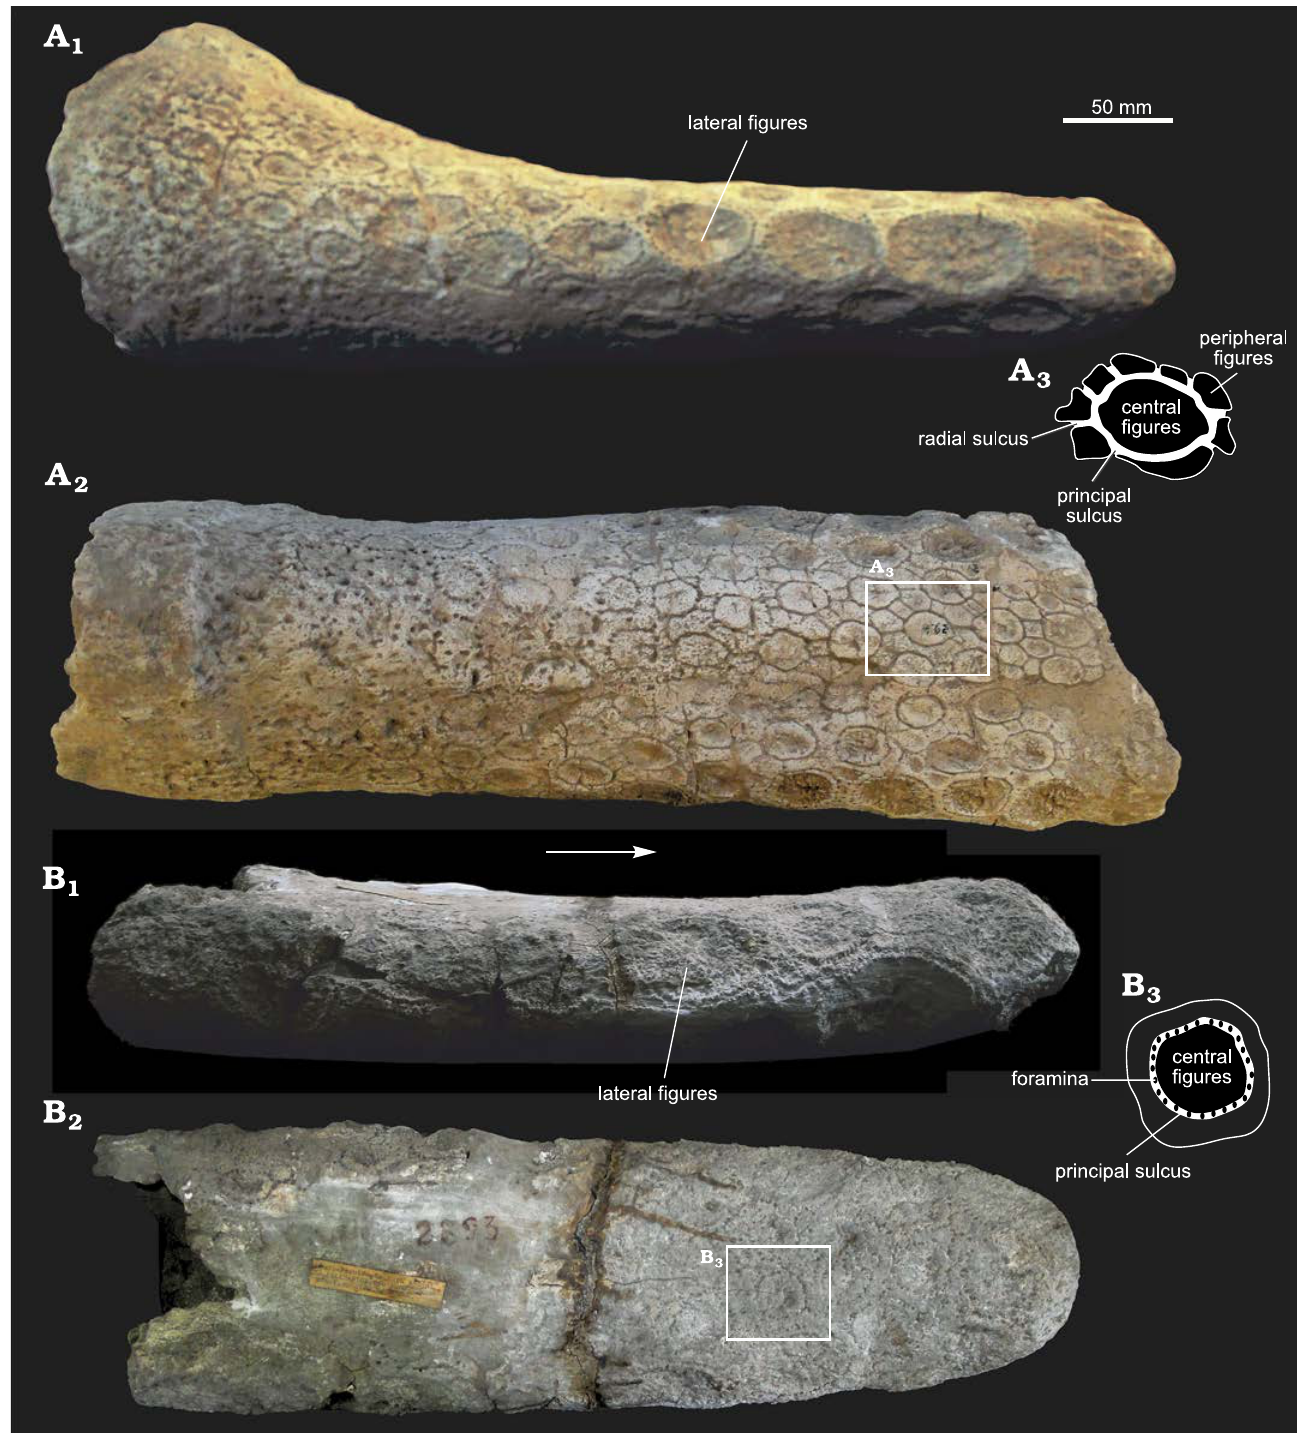
Fig. 7. Caudal tubes of doedicurine glyptodont Eleutherocercus solidus (Rovereto, 1914), from upper Miocene–Pliocene of Argentina. A . MLP 29-X-10-21, from Puerta de Corral Quemado (near the road to Loconte), unknown stratigraphic level; in lateral (A 1 ) and dorsal (A 2 ) views; drawing of detail of dorsal osteoderm (A 3 ). B . MACN 2893 (holotype of E. tucumanus Castellanos) from Tiopunco, unknown stratigraphic level; in lateral (B 1 ) and dorsal (B 2 ) views; drawing of detail of dorsal osteoderm (B 3